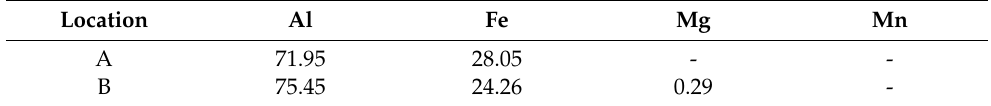
Table 4. Results of EDS point analysis (at. %).